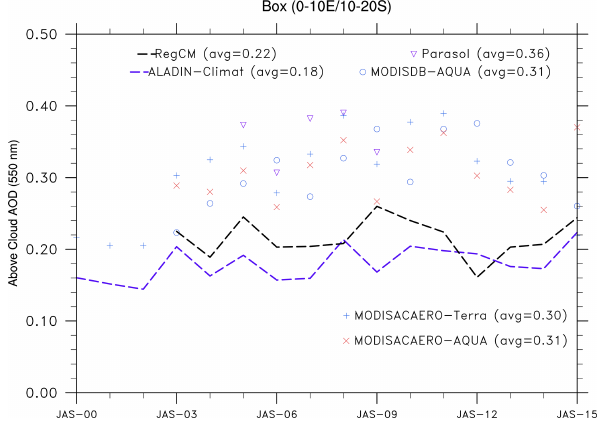
Figure 5. Seasonal (JAS) mean of the total ACAOD (550nm) aver- aged over the box_O. RegCM (2003–2015) and ALADIN (2000– 2015) SMK simulations and PARASOL (2005–2009), MODIS Deep Blue Aqua (2003–2015), MODISACAERO Terra (2000– 2015) and MODISACAERO Aqua (2003–2015) satellite observa- tions are reported.